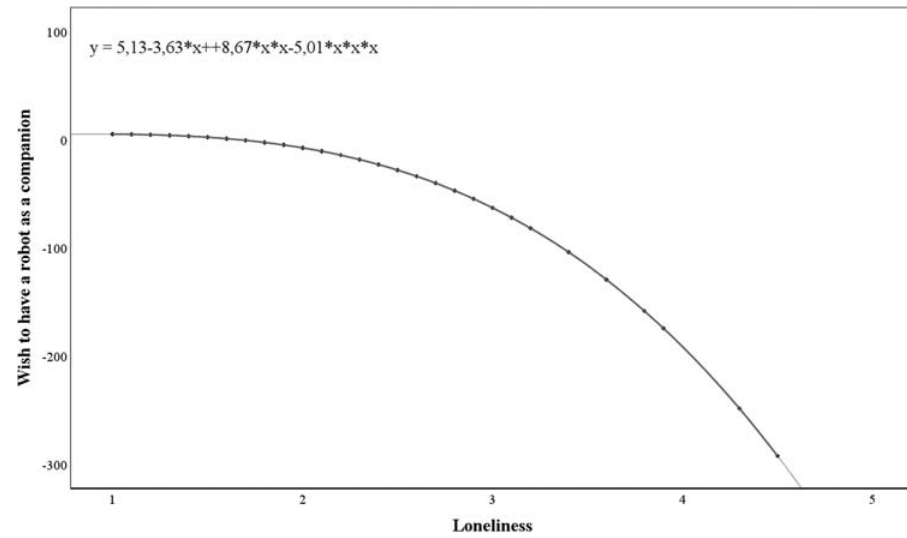
Figure 2: Wish to have a robot as a companion explained by Loneliness ( Intimate )